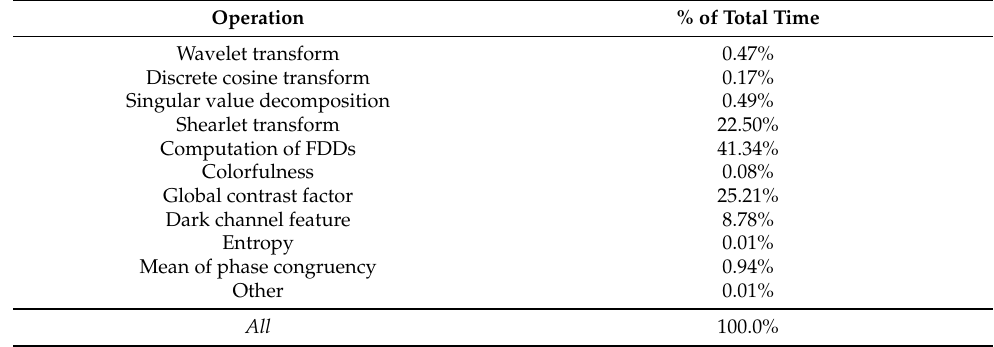
Table 16. Profile summary of FDD+Perceptual-IQA measured on KonIQ-10k [21]. It presents statis- tics about the overall execution and a representation of the time spent in different modules of FDD+Perceptual-IQA